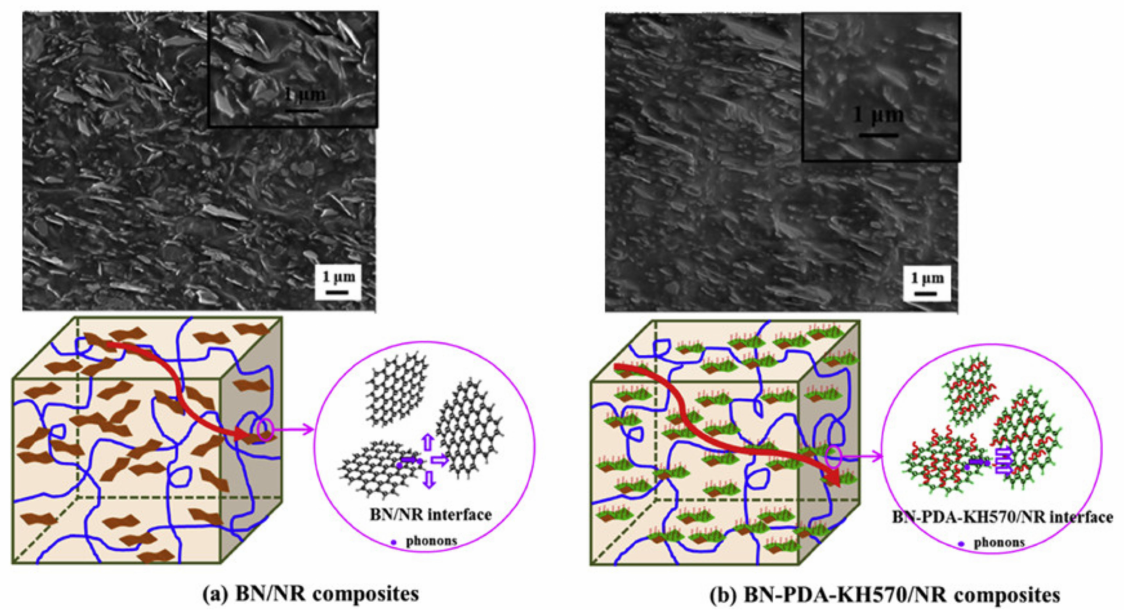
Figure 14. SEM images and heat dissipation/transport models for ( a ) BN/NR and ( b ) BN-PDA-KH570/NR nanocomposites. Adapted from [179]. Copyright© 2021 Elsevier Ltd. All rights